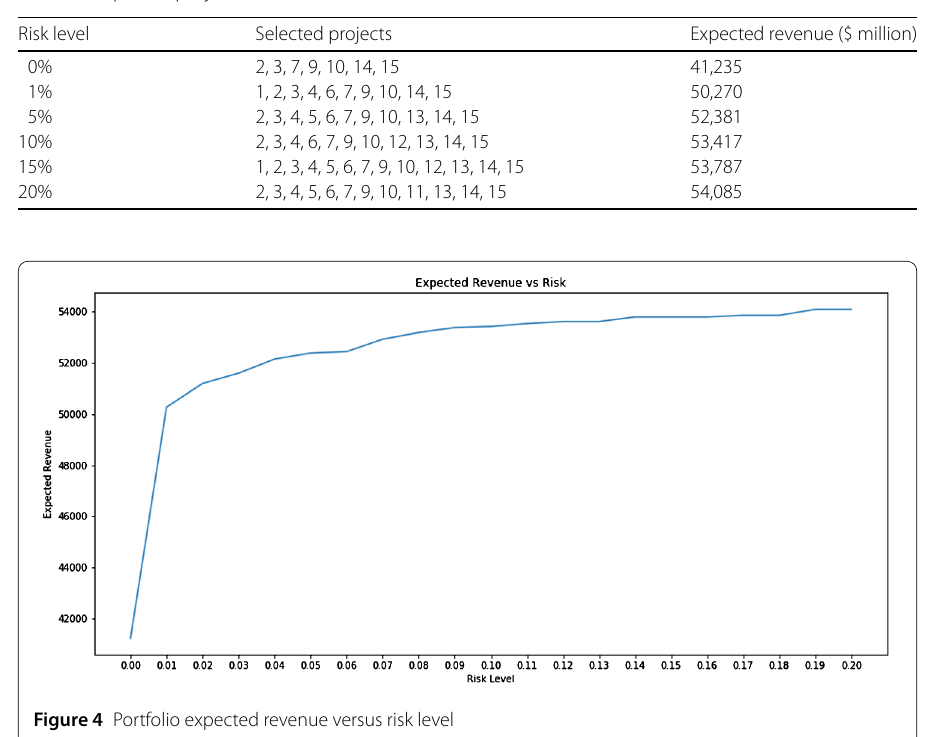
Figure 4 Portfolio expected revenue versus risk level